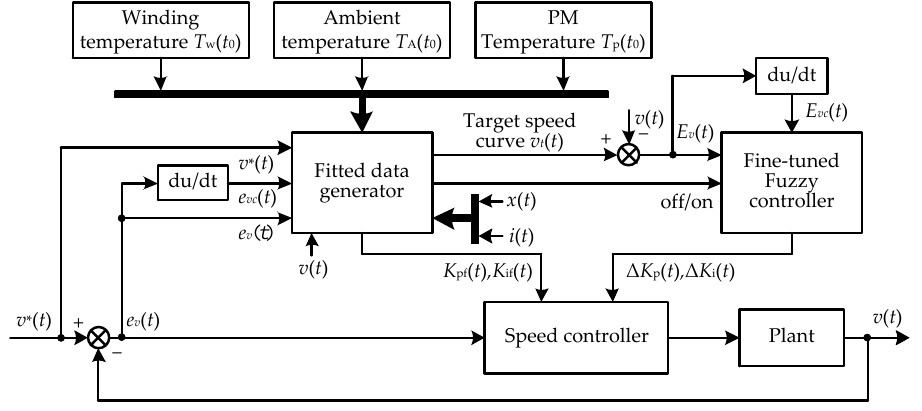
Figure 1. Schematic diagram of fitted adaptive fuzzy controller.